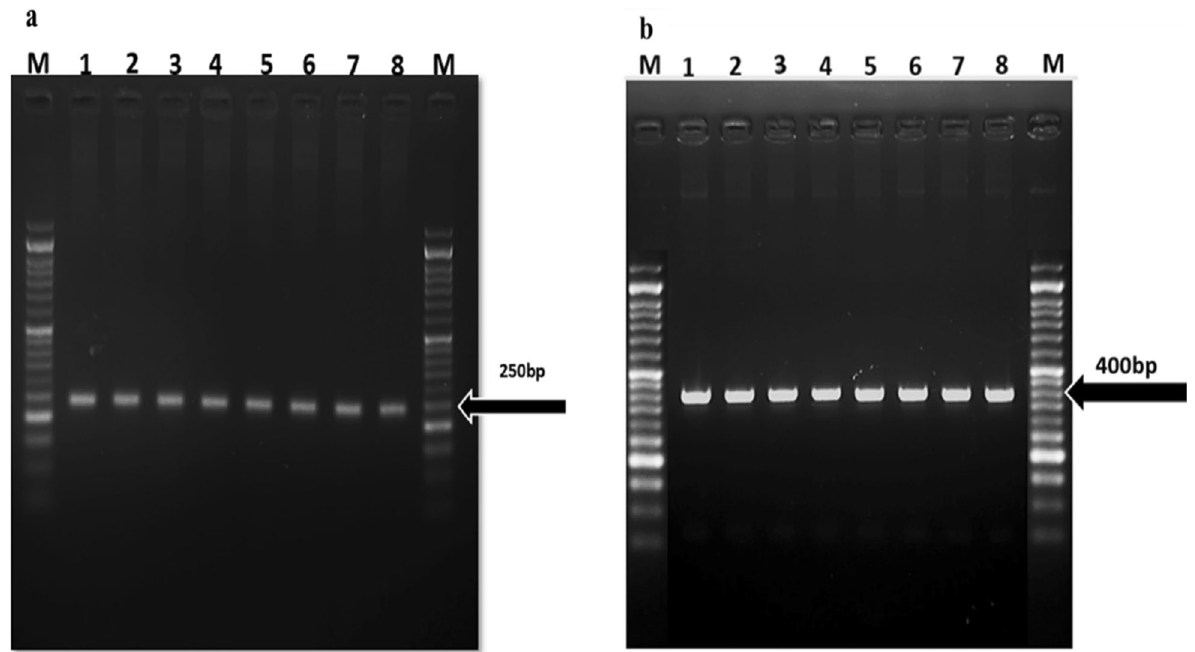
Fig. 2 Detection of the polymorphisms’ genotypes for representative digested samples using 2% agarose gel electrophoresis. a All lanes